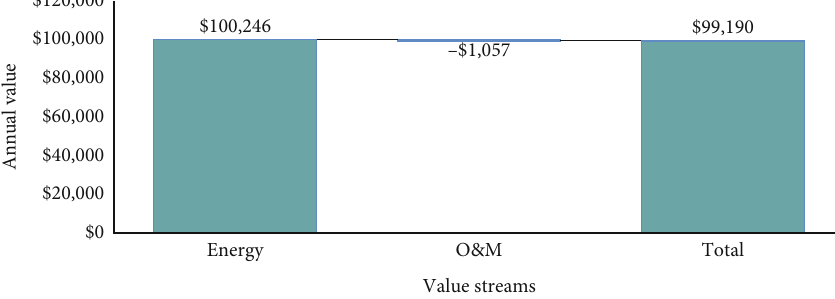
Figure 20: Categorized annual savings for a proposed system for Kenya.